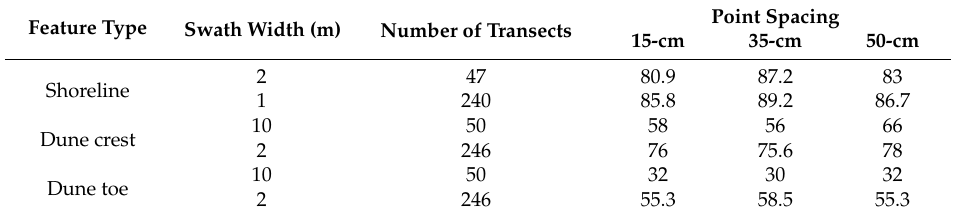
Figure 7. Feature positions extracted from two swath widths. ( a ) Map of geomorphic feature positions calculated from the 35-cm spaced UAS-SfM point cloud. Blue points represent shoreline; red represent dune toe; and yellow represent dune crest. ( b ) Success rate (percent of transects at which a feature was successfully solved) of shoreline, dune toe, and dune crest extraction from wide and narrow swaths (dotted and solid lines, respectively) plotted against average point spacing of the input point cloud. Table 2. Success rate of shoreline, dune toe, and dune crest by high- and low-resolution processing as extracted from the same point cloud with point spacing of 15, 35, and 50 cm. Success rate is the percent of transects at which a feature was successfully resolved.